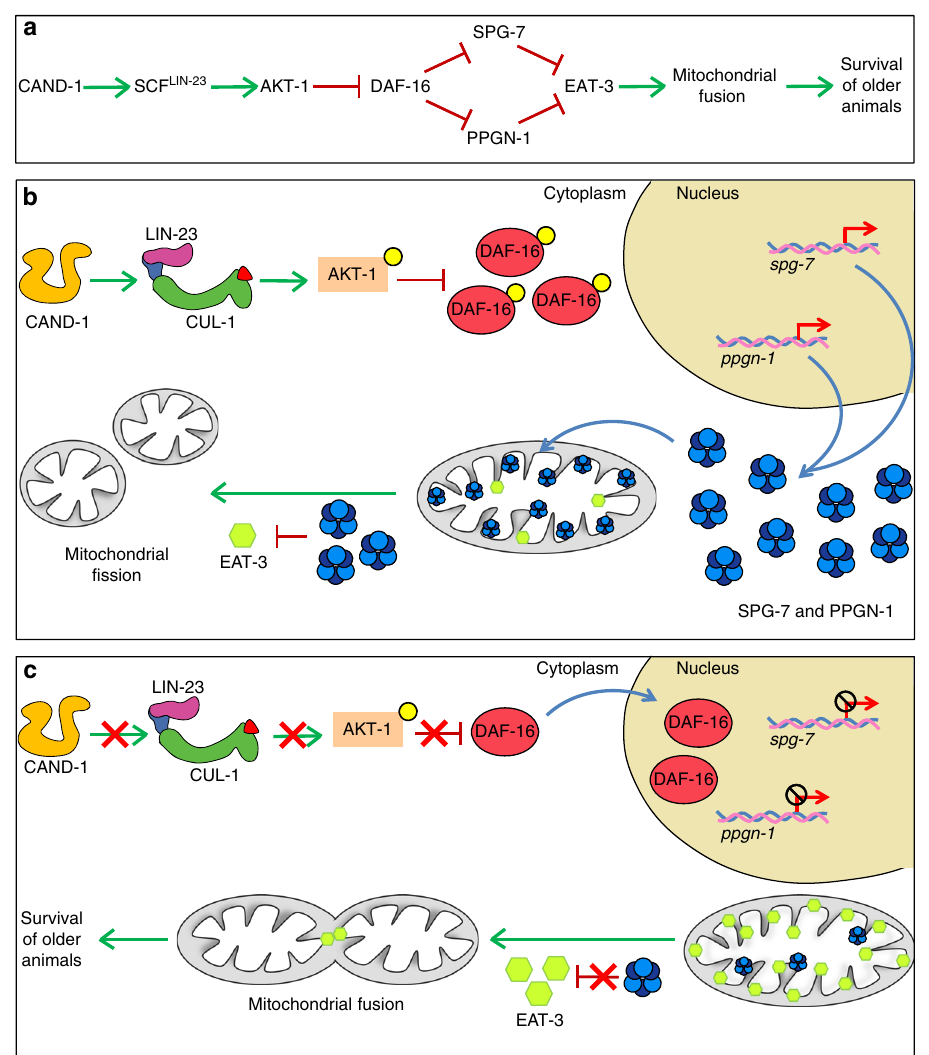
Fig. 4 Model for regulation of mitochondrial fusion. a Proposed linear pathway for CAND-1 and SCF LIN-23 regulation of mitochondrial fusion; see text for description. b , c Schematic of the proposed intracellular pathway regulating mitochondrial fusion and lifespan extension in the presence b or absence c of